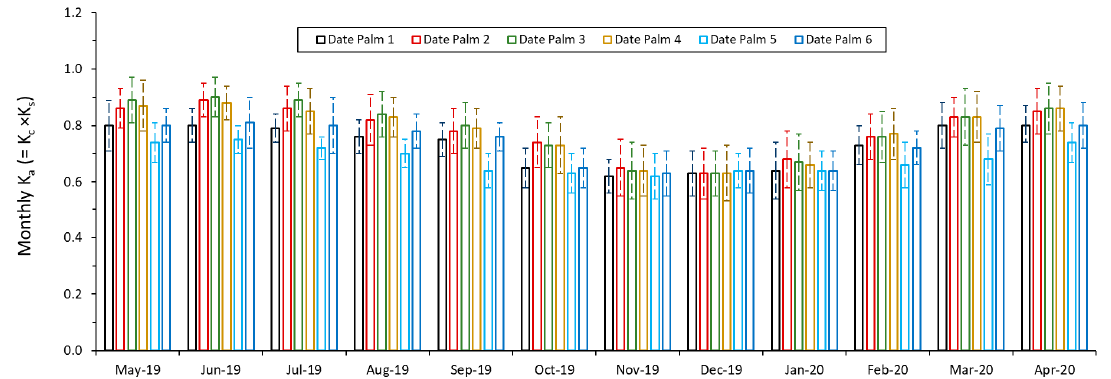
Figure 12. Calculated monthly actual crop coefficient (K a ) values at the experimental date palms over the 12-month study period. The observed daily actual evapotranspiration (ET a ) and spatial CIMIS reference evapotranspiration (ET o ) in each of the experimental date palms were used to compute the monthly K a values. Standard deviation (SD) of the corresponding K a values is shown on the bars.